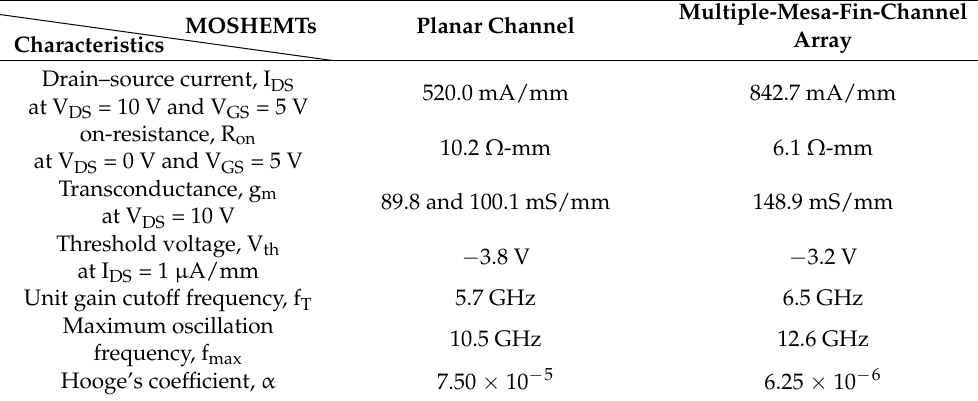
Table 1. Performance comparisons of the double-channel MOSHEMTs with planar channel and multiple-mesa-fin-channel